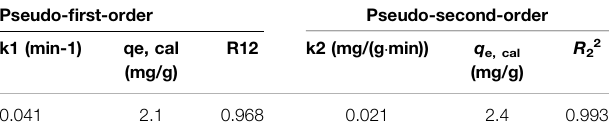
TABLE 2 | Kinetics parameters. Pseudo- fi rst-order